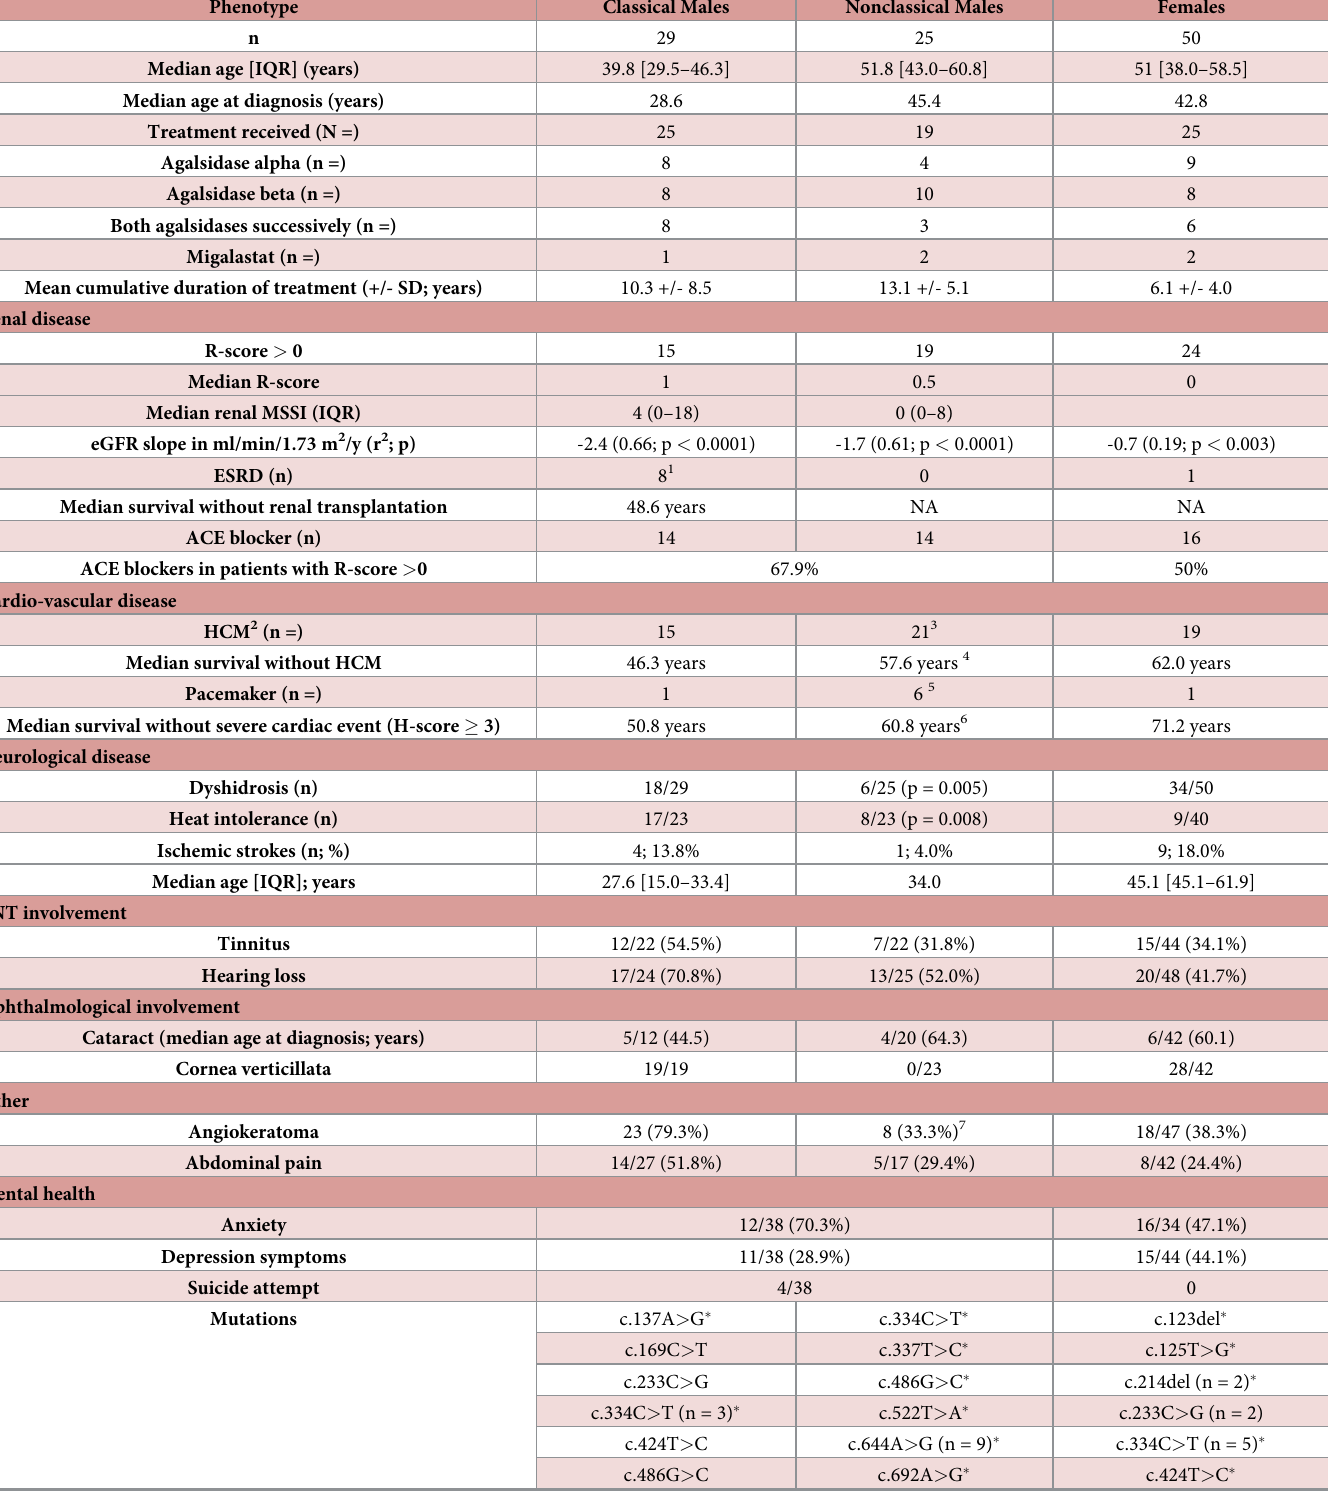
Table 2. Characteristics of patients stratified by clinical phenotype defined with the FFABRY scoring